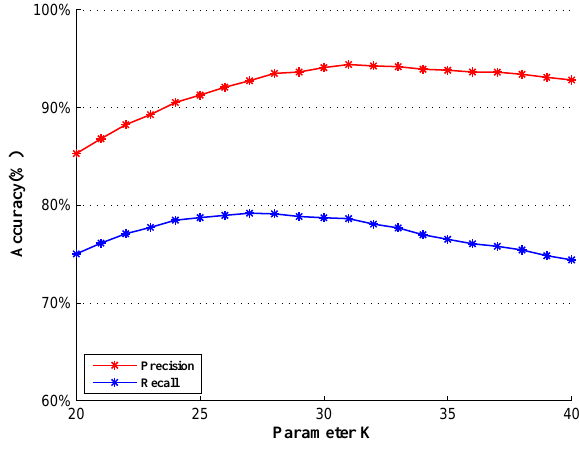
Figure 4. Performance of local feature matching with different K